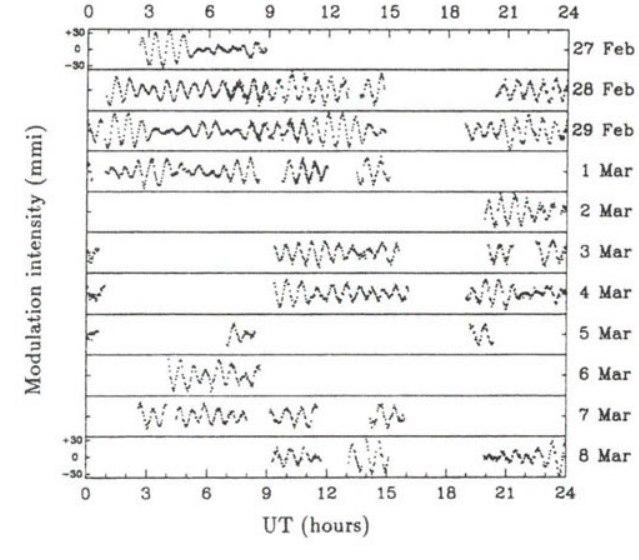
Fig. 4. The complete WET data set obtained on the object CD —24°7599 during the 1992 XC0V7 campaign. The reduced data re- present 2 min integrations and are plotted in modulation intensity units, with 1000 mmi = 100 %, so 30 mmi corresponds to a 3 % intensity mod- ulation of the mean light level. The central panels of the graph present data obtained in New